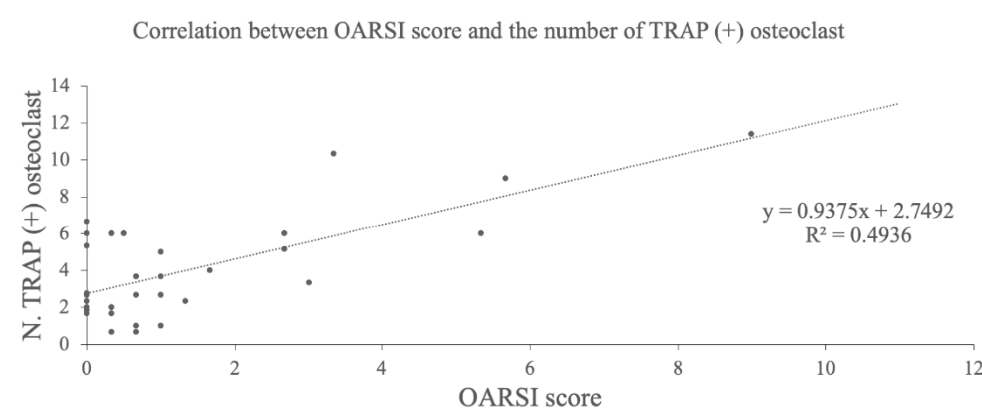
Figure 5. Correlation analysis between OARSI score and the number of TRAP-positive osteoclasts. BO; Boiogito, DMM; Destabilization of the medial meniscus, OARSI; Osteoarthritis Research Society International, TRAP; Tartrate-resistant acid phosphatase.